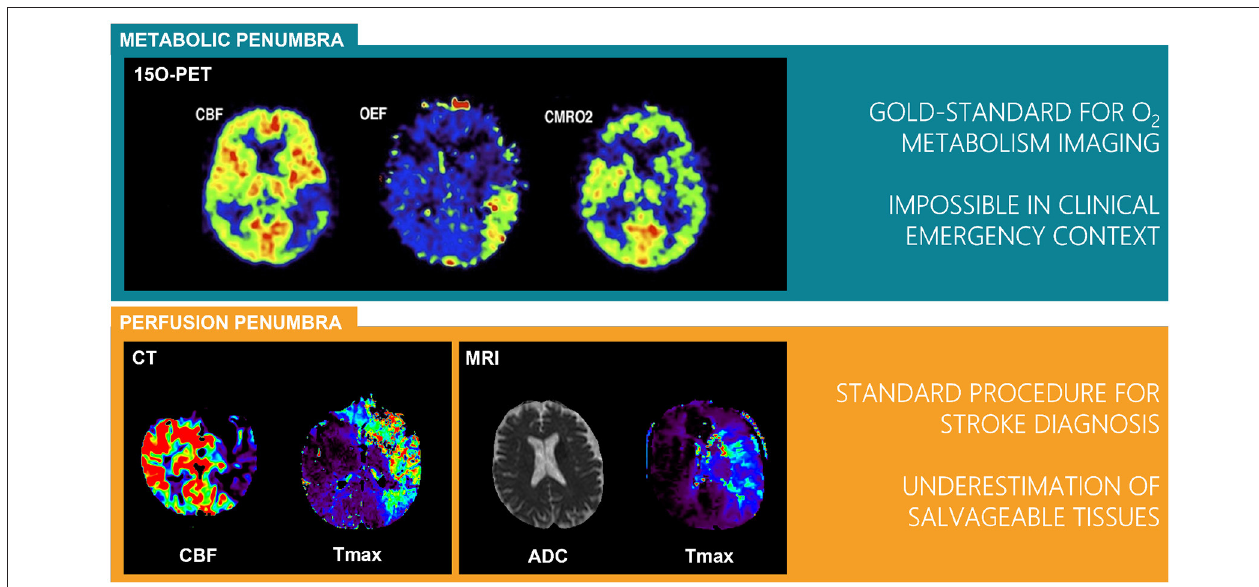
FIGURE 2 | Definitions of perfusion and metabolic penumbra from the gold standard [ 15 O]-Positron Emission Tomography (PET) to the widely distributed Computed Tomography (CT) and Magnetic Resonance Imaging (MRI) perfusion imaging. PET images published in JNM. Heiss WD. Radionuclide imaging in ischemic stroke. J Nucl Med. (2014) 55:1831–41. © SNMMI.; CT and MRI images from Olea Medical. CBF, cerebral blood flow; CMRO 2 , cerebral metabolic rate of oxygen; OEF, oxygen extraction fraction; ADC, apparent diffusion coefficient; Tmax, time to maximum of residual